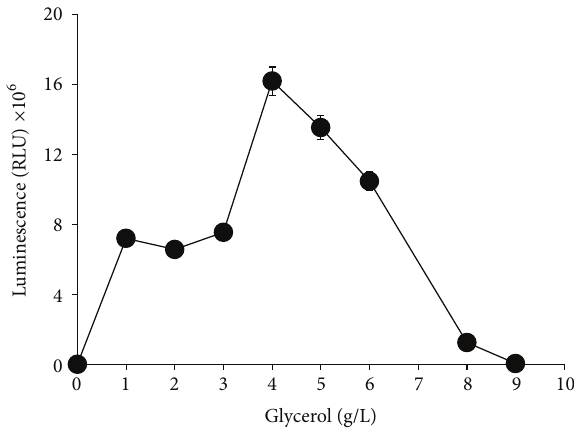
Figure 2: Effects of different carbon sources on bioluminescence production of Photobacterium sp. strain MIE. The isolate was grown in luminescence media containing 1g/L of carbon sources incubated in orbital shaker (100rpm) for 12 hours at room temperature. Data is mean ± standard error of the mean ( 𝑛 = 3 ). The cultures were grown without any carbon source as control.